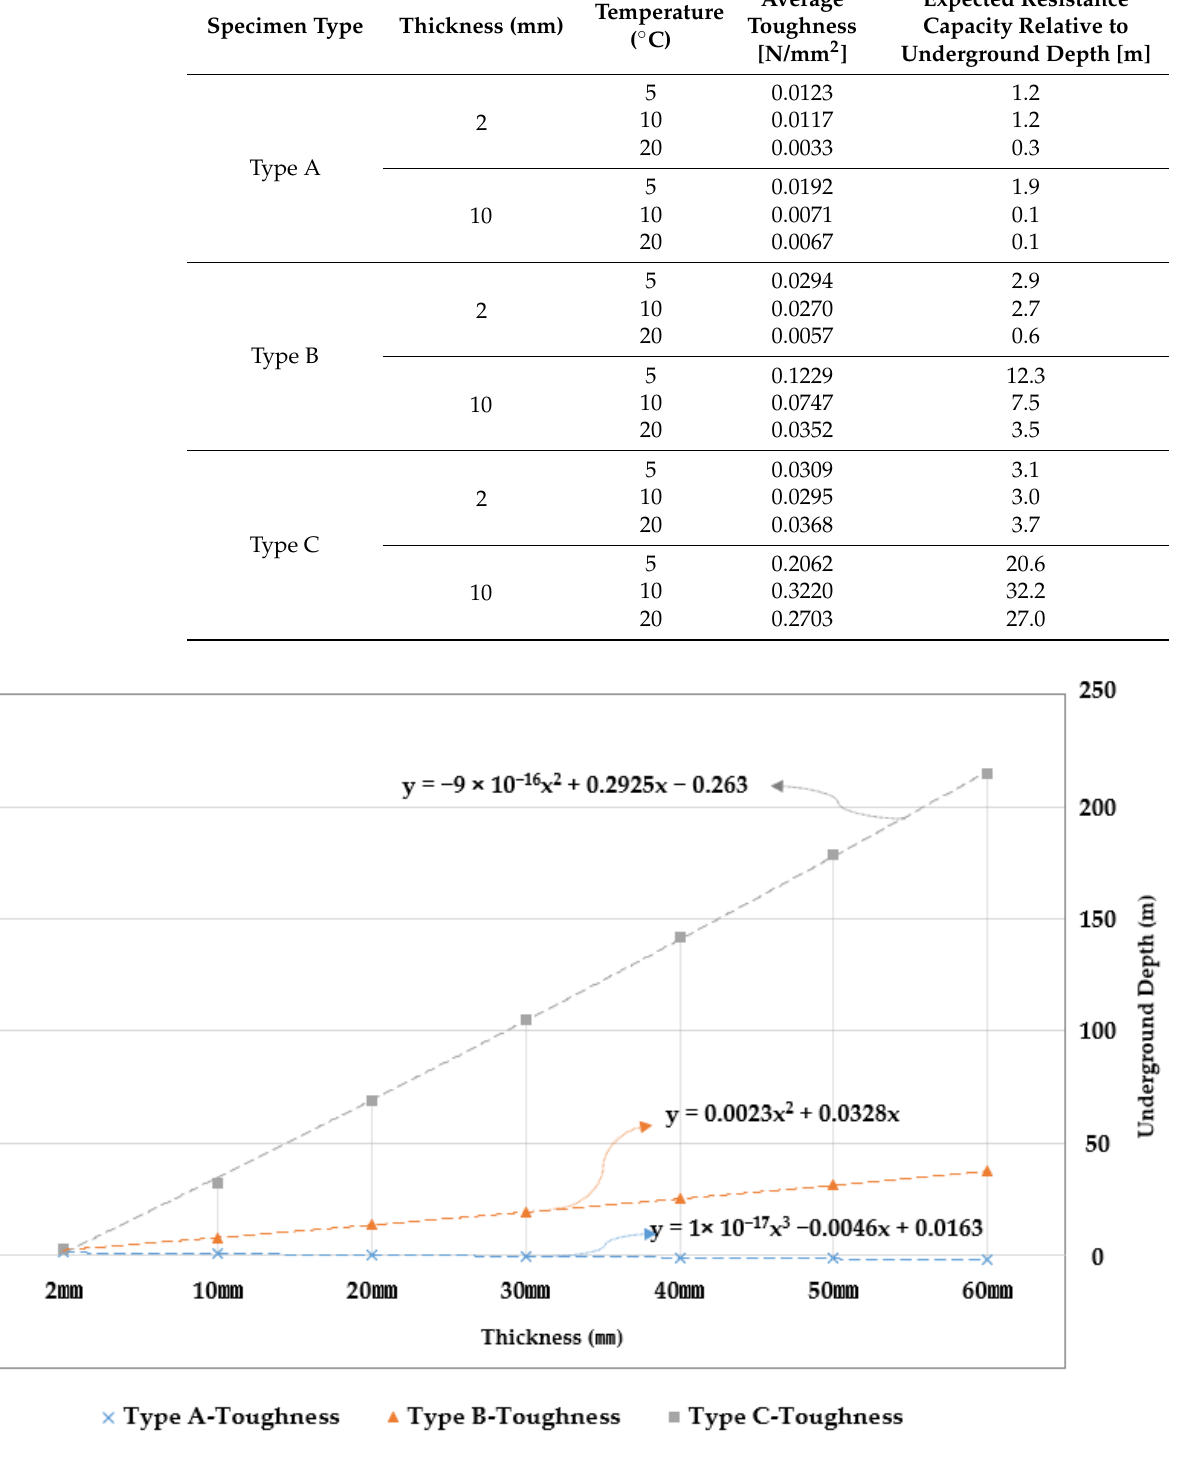
Figure 13. Prediction depth and toughness according to thickness by each SPRG